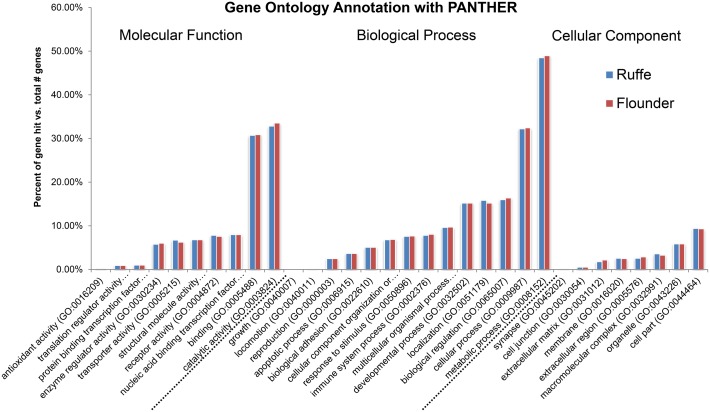
Functional classification and comparison of transcriptomes of the ruffe and European flounder.GO analysis and annotation of the genes were performed with PANTHER [35].